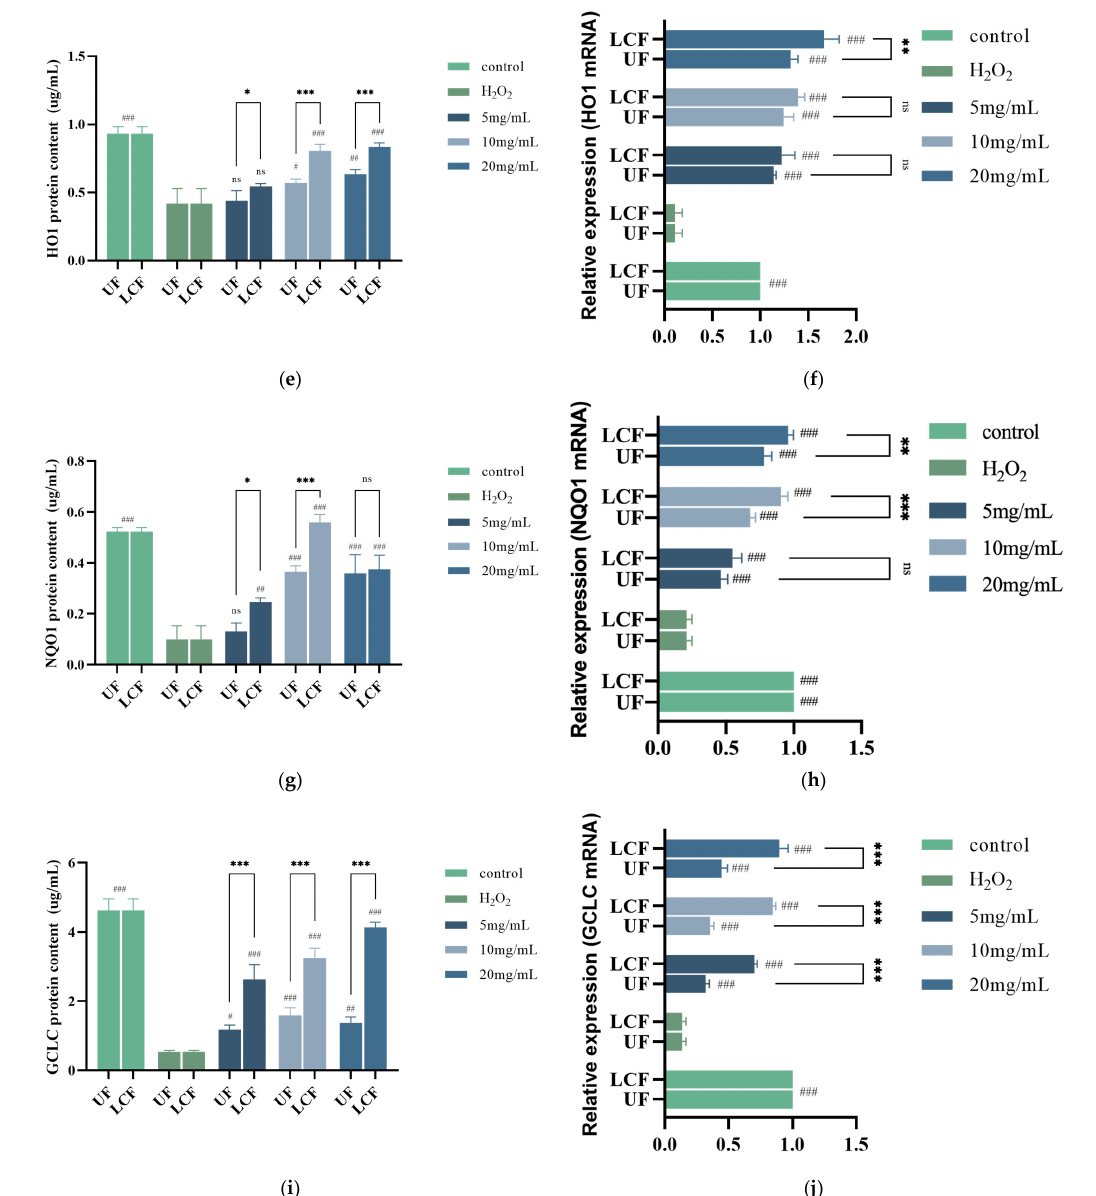
Figure 9. Effects of UF and LCF on Nrf2/Keap1 signaling pathway. Effects of UF and LCF on Nrf2 content ( a ) and mRNA expression ( b ), and Keap1 content ( c ) and mRNA expression ( d ). Effects of UF and LCF on activity of NQO-1 ( e ) and mRNA expression ( f ), HO-1 content ( g ) and mRNA expression ( h ), and GCLC content ( i ) and mRNA expression ( j ). UF: unfermentation; LCF: single microbial fermentation with L. curvatus . Analysis of significant differences between each group and H 2 O 2 model group, #: p < 0.05; ##: p < 0.01; ###: p < 0.001.; comparison of each group between UF and LCF, *: p < 0.05; **: p < 0.01; ***: p < 0.001 ; ns: p > 0.05.